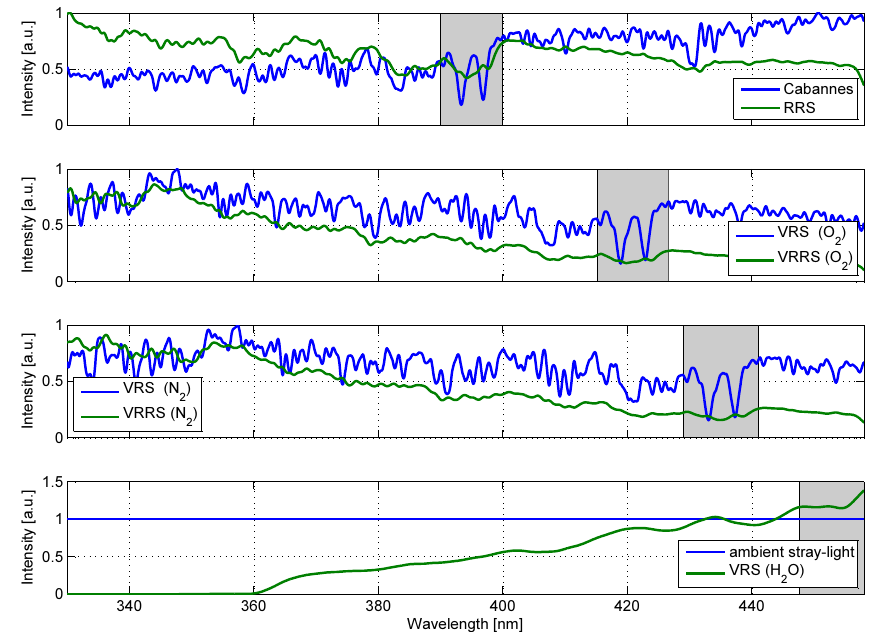
Figure 2. Calculated intensities (in arbitrary units) for purely Rayleigh scattered light (Cabannes), rotational Raman scattered light (RRS), vibrational Raman scattered light (VRS), and combined scattering (VRRS) due to N 2 , O 2 and liquid water as well as assumed instrumental stray-light as a function of wavelength at a spectral resolution of 0.5nm. The apparent optical depths I add /I 0 according to Eq. (18) are shown in Fig. 3. The relative magnitudes for each of the effects are arbitrarily scaled. Note the red-shift in the VRS(O 2 ) and VRS(N 2 ) spectrum compared to the solar atlas; the Ca-II lines and their respective ghost lines for inelastic scattering on N 2 , O 2 and liquid water are marked gray. For the absolute magnitudes of the cross-sections compare Table 9.